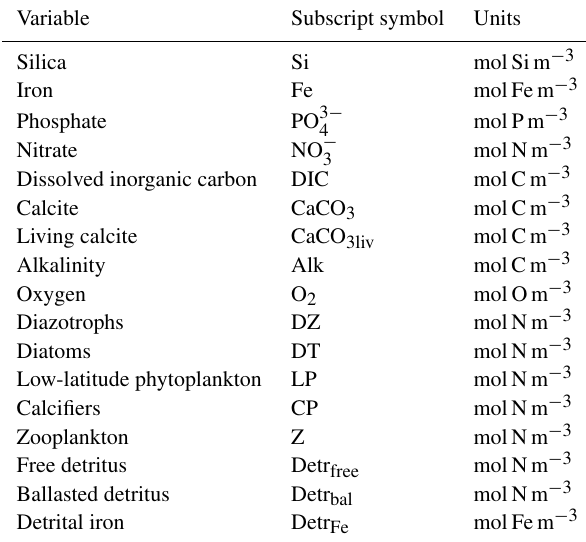
Table 1. KMBM3 state